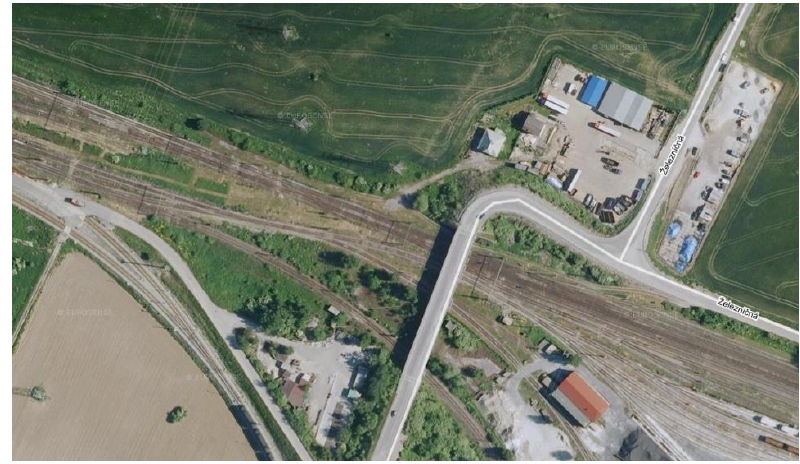
Figure 7. Aerial view of the analyzed road bridge located in the scanned area.